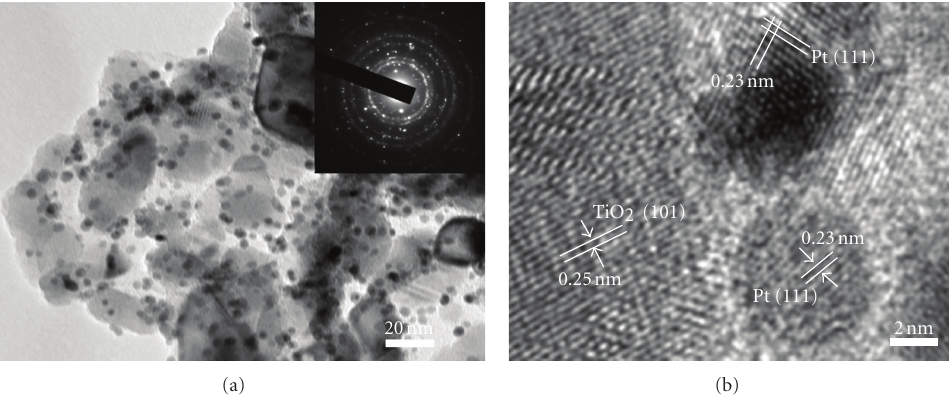
Figure 2: (a) TEM and (b) HRTEM images of Pt nanoparticles deposited on hollow Nb-TiO 2 nanosphere supports with 20wt% Pt loading. Pt NPs are single crystal, 4 nm in average size and uniformly dispersed on the surface of hollow Nb-TiO 2 nanosphere supports.